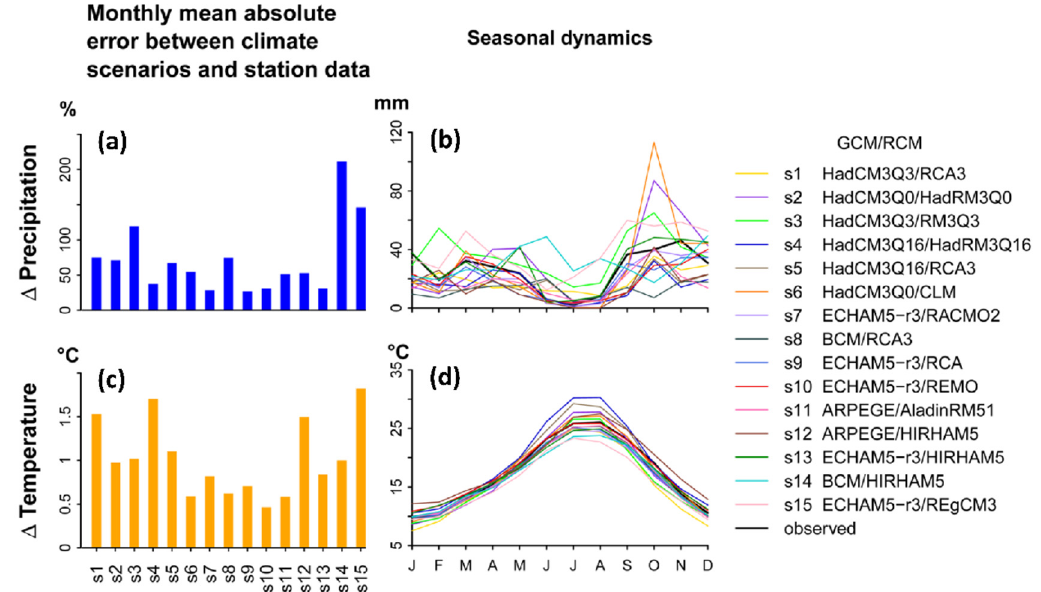
Figure 2. Evaluation of climate scenario data for the historical period by comparing the modeled and observed station data in the catchment for the years 2000–2011: Mean monthly absolute error between modeled and observed station data for precipitation ( a ) and temperature ( c ); and average seasonal dynamics of modeled and observed station data for precipitation ( b ) and temperature ( d